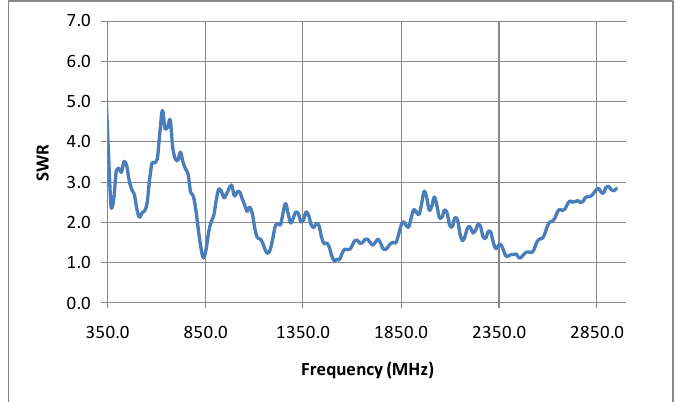
Figure 4. SWR response of the imaging antenna, of Figure 1, across the frequency range from 350 MHz through 2.95